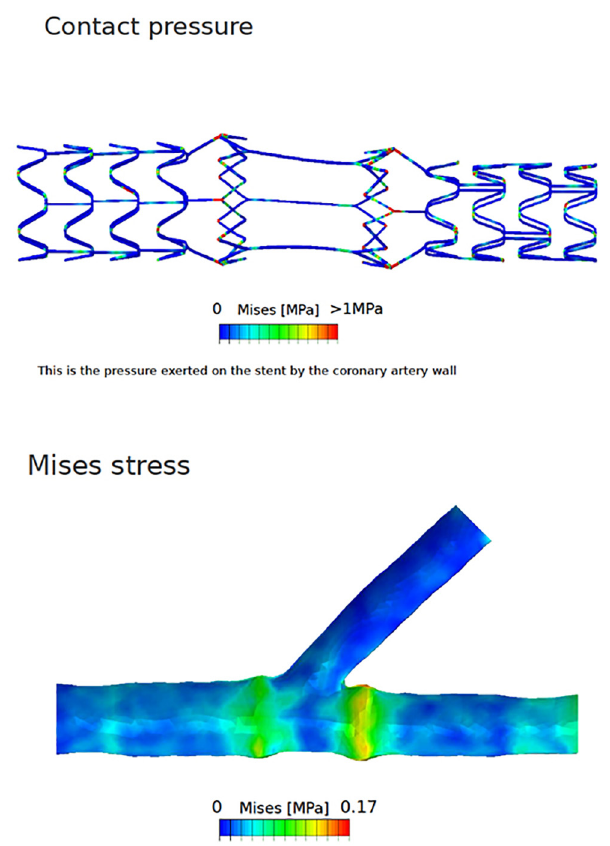
Fig 2. Stage 1 result of the finite element simulations — Stresses on the stent (upper panel) and stresses on the arterial wall (lower panel).